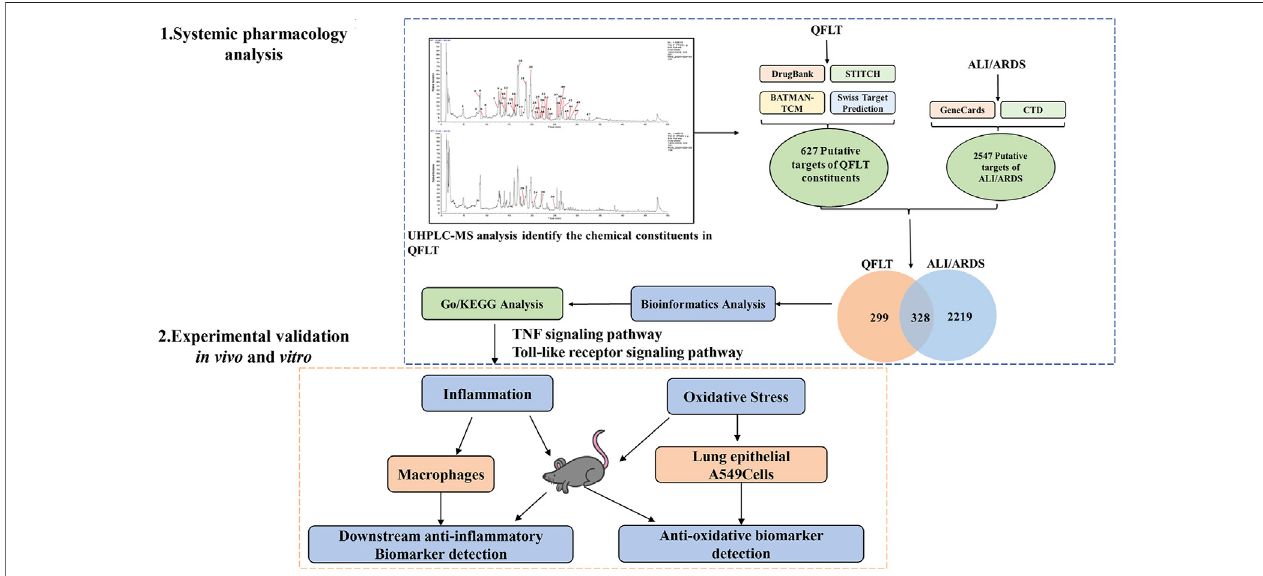
FIGURE1| Proceduresofasystemicpharmacology-basedstrategytoinvestigatetheeffectofQingfei Litan(QFLT) decoction against Acute lunginjury(ALI)/acute respiratory distress syndrome (ARDS).